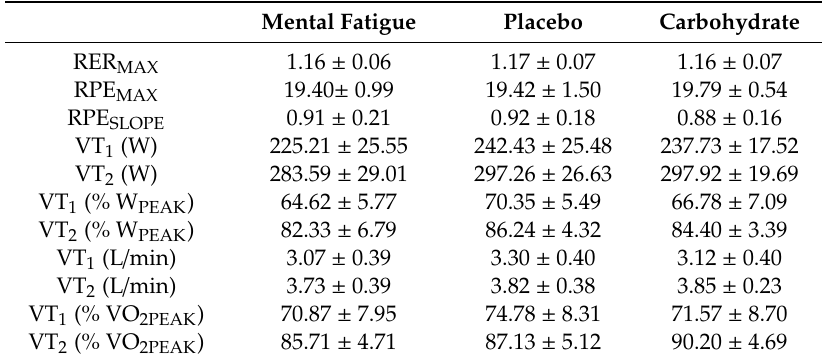
Figure 2. Peak power output (W PEAK , upper panel ), time to exhaustion ( middle panel ), and the peak of O 2 uptake (VO 2PEAK , bottom panel ) in mental fatigue, and mental fatigue combined with placebo and carbohydrate mouth rinse. Table 2. Maximal incremental test outcomes during mental fatigue, and mental fatigue combined with carbohydrate and placebo mouth